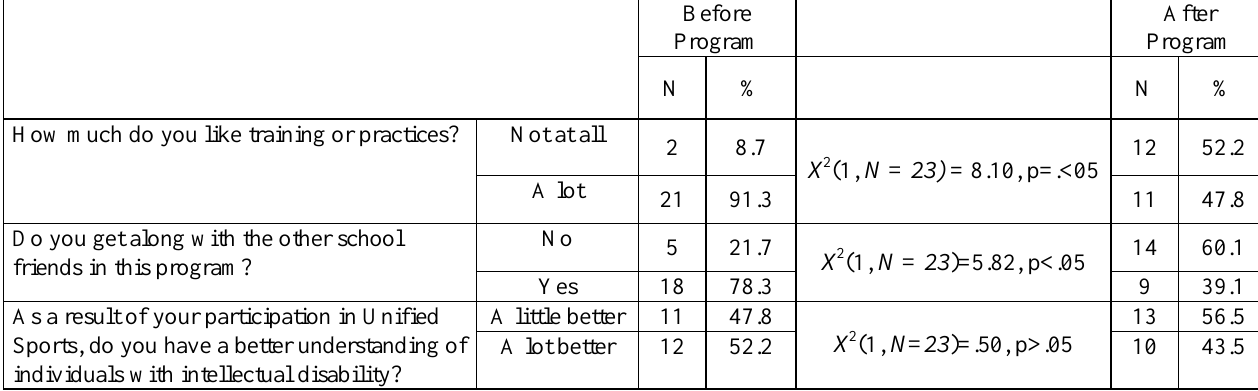
Partners’ response to Unified Sport Questionnaire before and after program